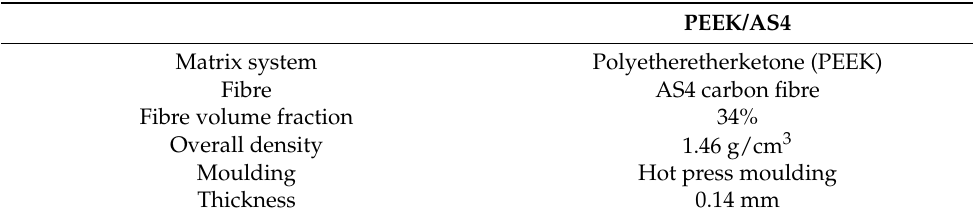
Table 1. The properties of the PEEK/AS4 prepreg.